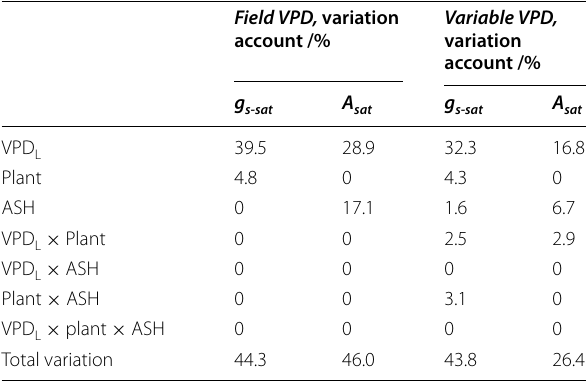
VPDL refers to vapour pressure deficit of the leaf, plant refers to the individual plant measured, and ASH refers to accumulated stress hours